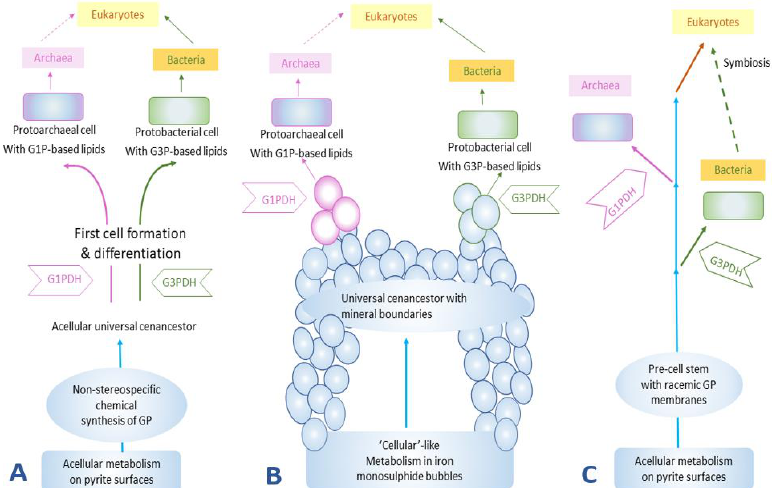
Figure 3. The formation of lipid membranes in primitive organisms: ( A ) the emergence of cellular life on pyrites, or more generally ‘minerals’ [40], ( B ) the emergence of life on monosulphide bub- bles around hydrothermal vents [41], and ( C ) the non-stereospecific formation of the GP and the subsequent evolution of enzymes G I PDH and G 3 PDH to catalyze the formation of stereospecific GP [42]. GP stands for glycerol phosphates, G 1 P stands for sn -glycerol-1-phosphate, and G 3 P stands for sn -glycerol-3-phosphate. This figure was redrawn and reprinted with permission from [35]; Copyright © 2004 Elsevier.